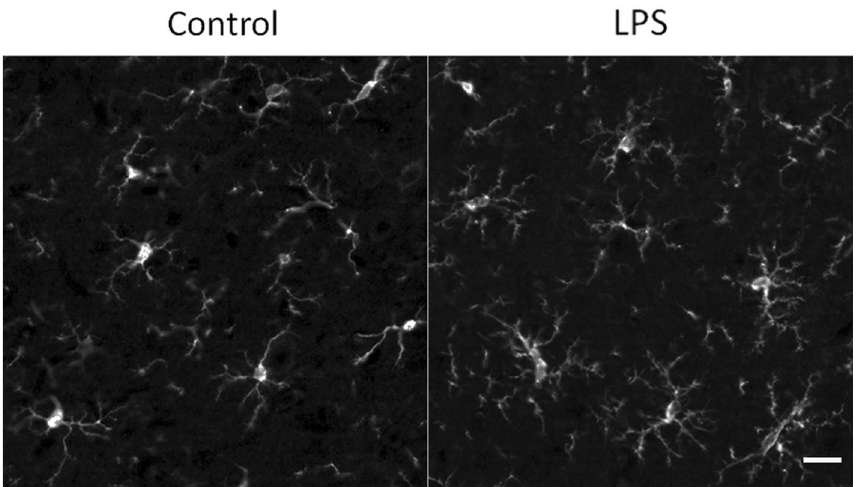
Figure 1. Effect of LPS ip injection on the morphology of cortical microglia. Representative views of microglia in coronal sections of the cerebral cortex (dorso medial area), 24 h after i.p. injections with LPS or vehicle (Control). The cells were stained with anti-Iba1 antibody as described previously 26 . The LPS proinflammatory treatment resulted in changes in microglia cell morphologies including proximal thickening and increased short secondary branching of the cell processes leading to a “bushy like” appearance. Scale bar: 20 µm.